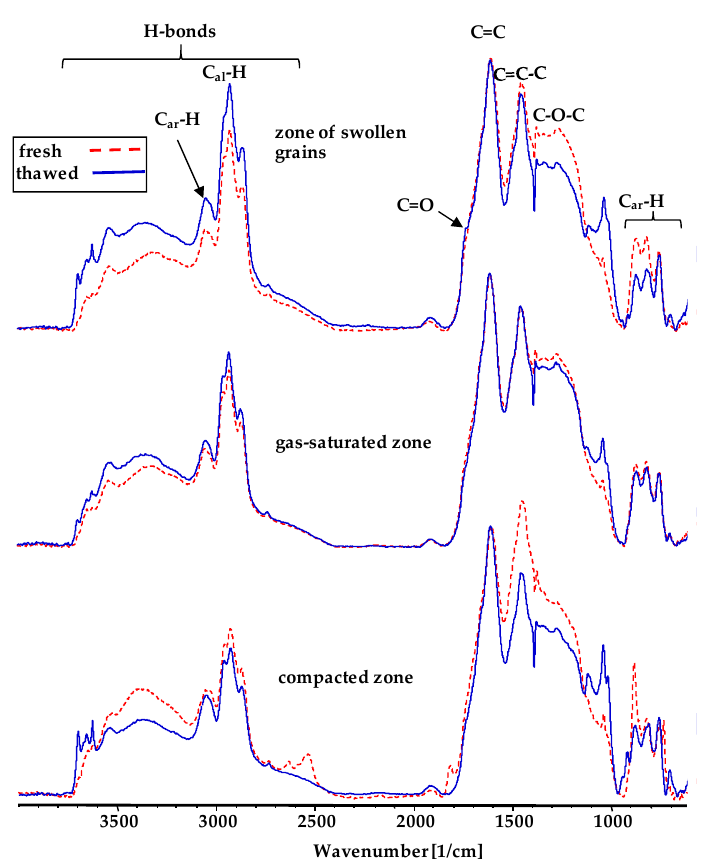
Figure 5. The Attenuated Total Reflectance (ATR) spectra of the material extracted from the zones of plastic layer.